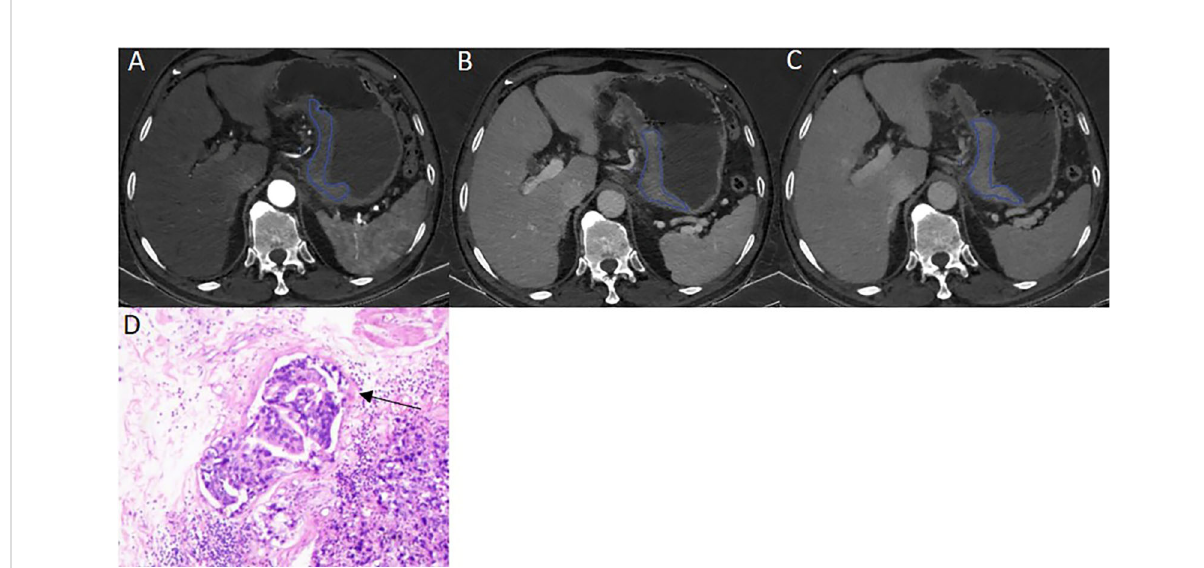
FIGURE 2 A 57 years old male patient with pathologically con fi rmed gastric adenocarcinoma, staging of pT4aN3aM0, LVI positive. The tumor thickness was 21.72mm, Borrmann classi fi cation of III. (A) Iodine map at arterial phase, tumor was hyperintense, IC value was 23.11 (100 m g/ml); (B) Iodine map at venous phase, IC value was 37.65(100 m g/ml); (C) Iodine map at delay phase, IC value was 38.94 (100 m g/ml); (D) The histopathology (HE, magni fi cation: ×200) showed adenocarcinomas cells in fi ltrate into lymphovascular structure (arrow).